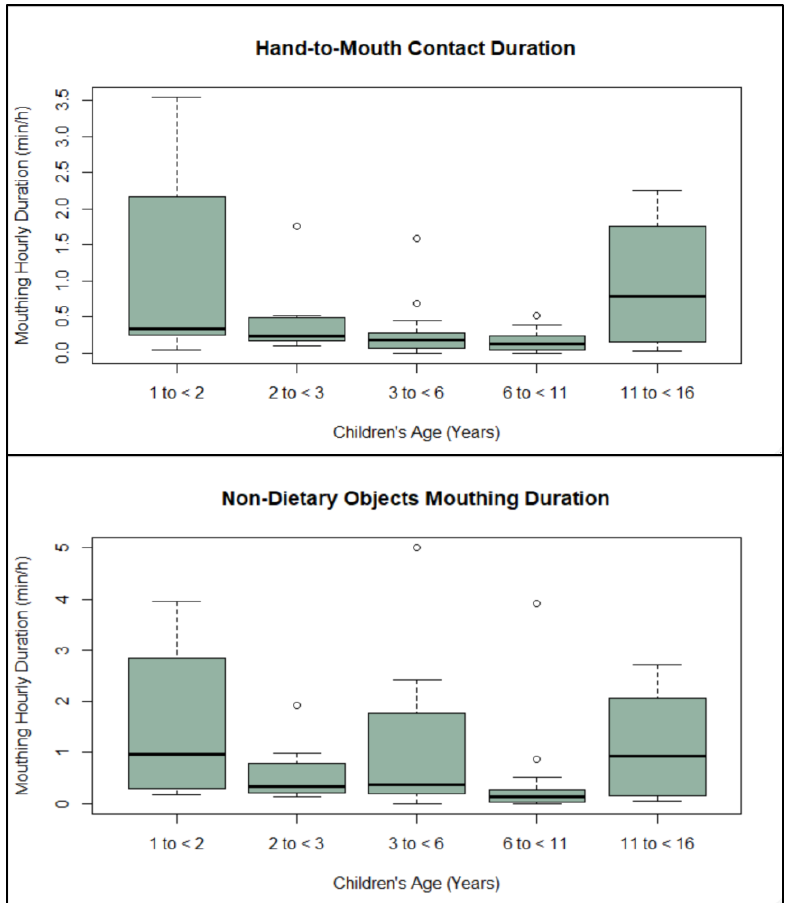
Figure 1. Mouthing hourly duration (min/h) with non-dietary objects and hands while playing on turf by age groups.